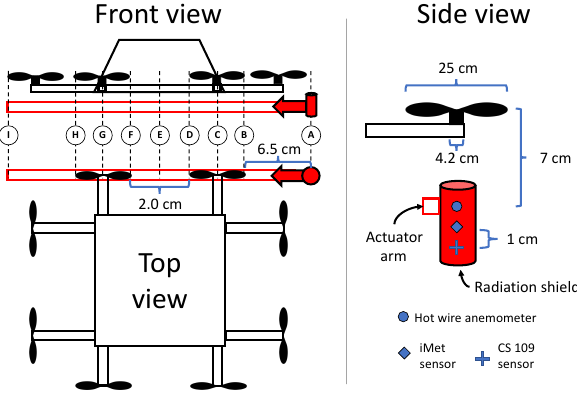
Figure 2. Schematic and dimensions of the rwUAS used in this study (drawing not to scale). In the front and top views, the lin- ear actuator arm is represented by the red rectangle outline, and the sensor package as a red circle. The arm was displaced from point A to point I, directly underneath the motor mounts and one pair of propellers as seen in the top and side views. Point B represents the tip of propeller 1, point C is directly under motor 1, D is the other side of the same propeller. Point E is halfway between the two pro- pellers, and points F–H are symmetrical to points